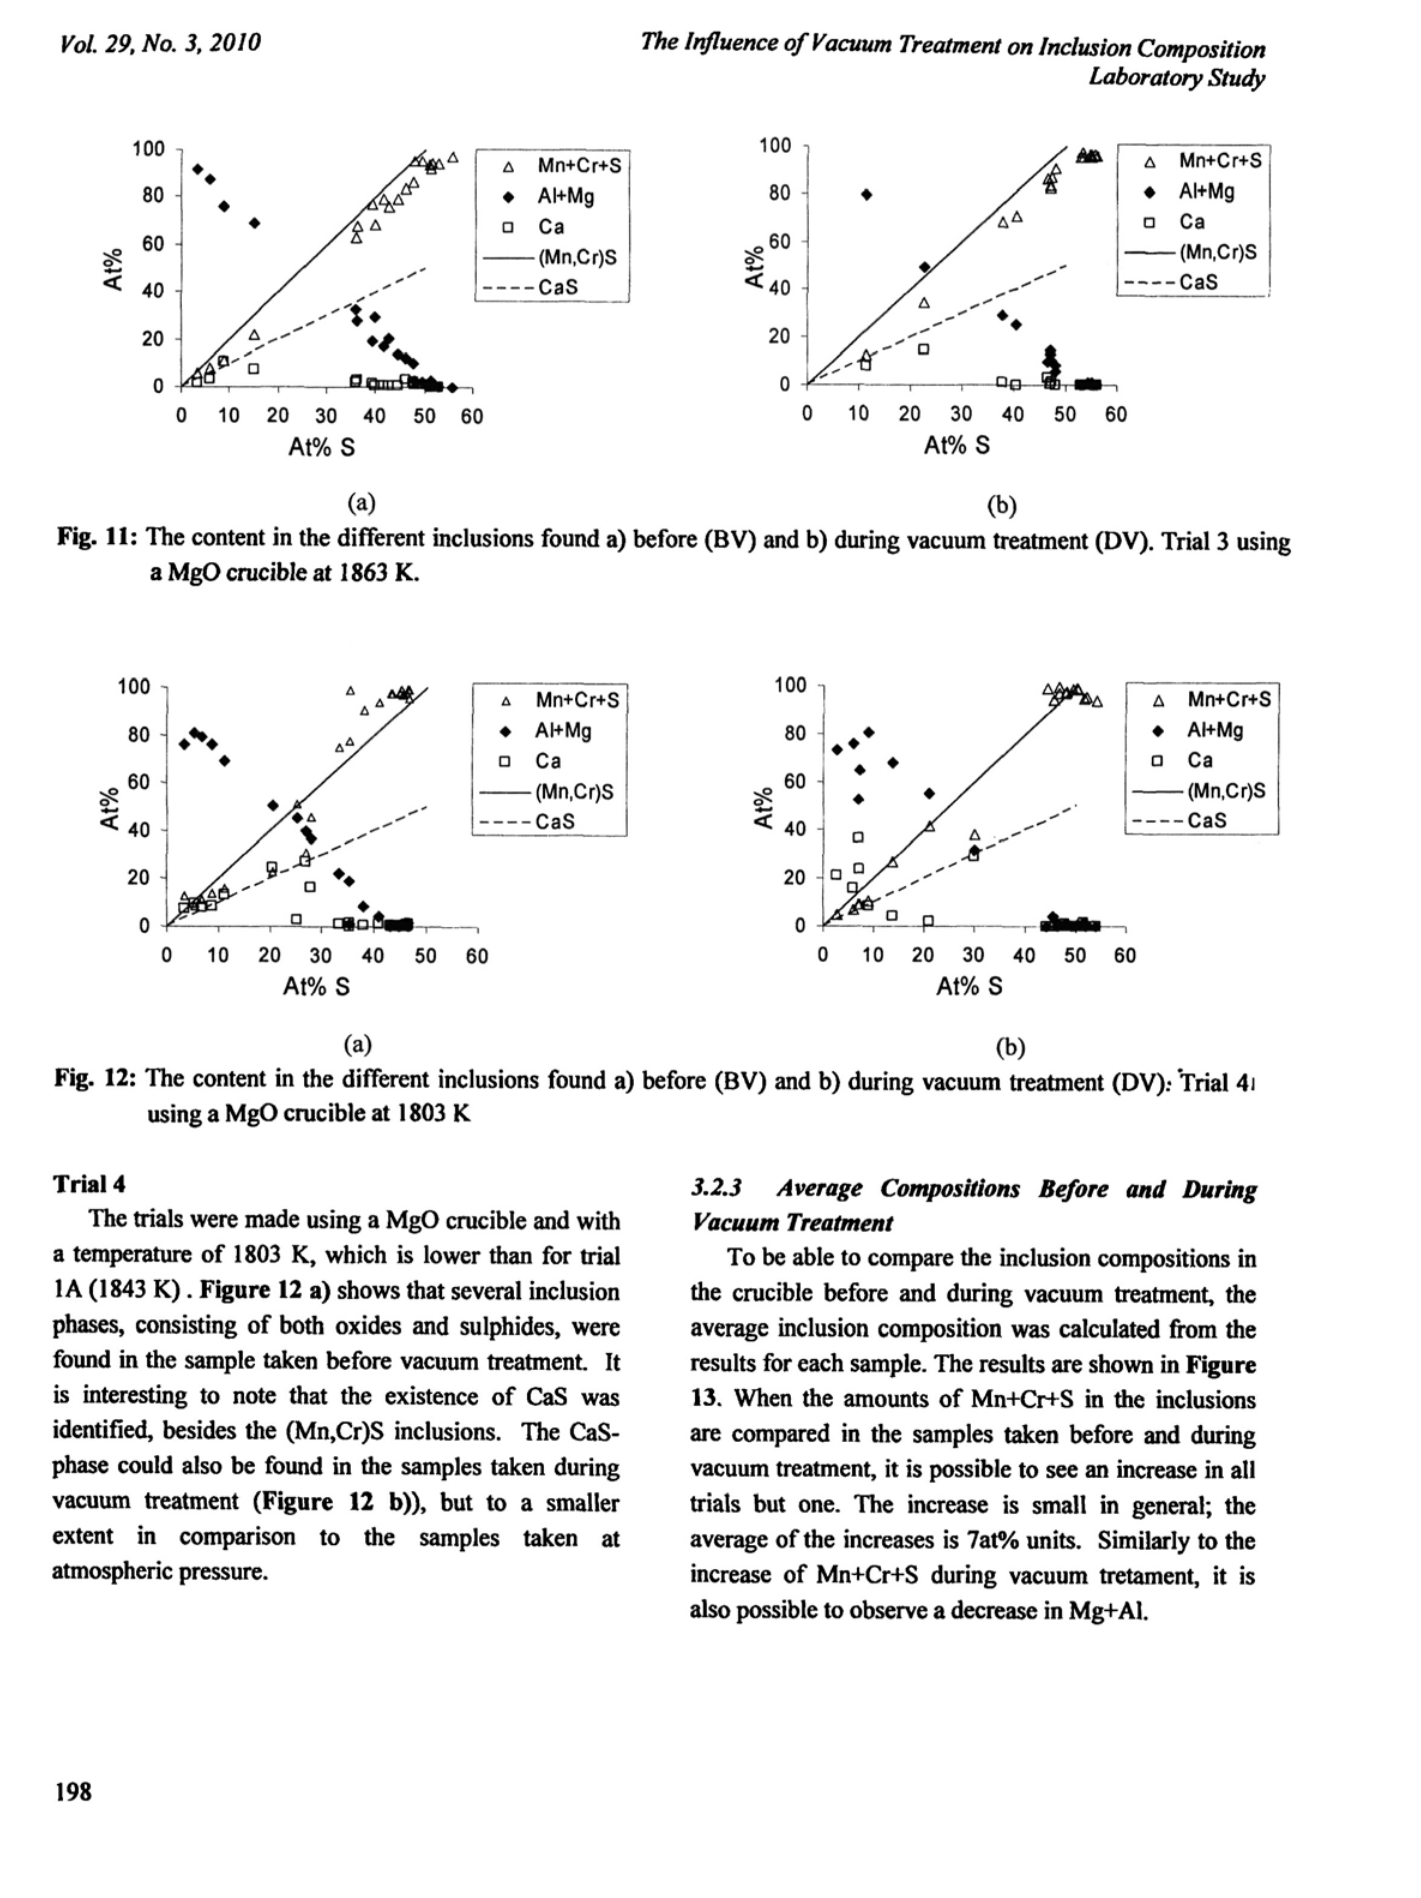
Fig. 11: The content in the different inclusions found a) before (BV) and b) during vacuum treatment (DV). Trial 3 using a MgO crucible at 1863 K.